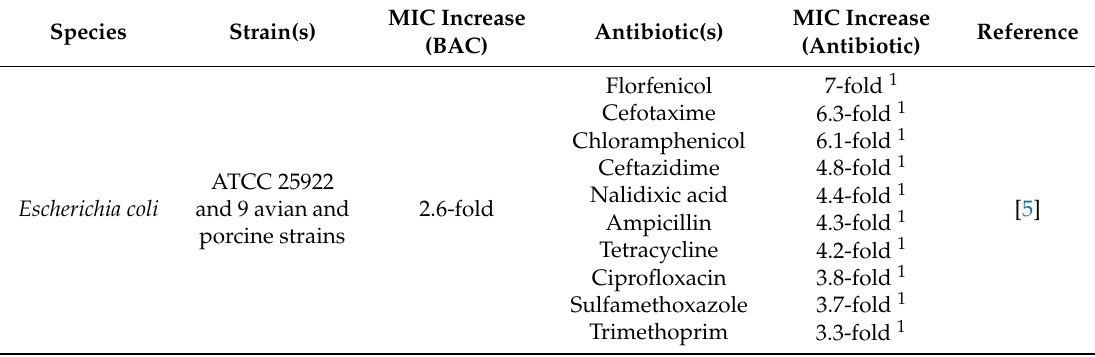
Table 1. Gram-negative species with increased antibiotic tolerance after various types of low level exposure (<MIC value) to benzalkonium chloride